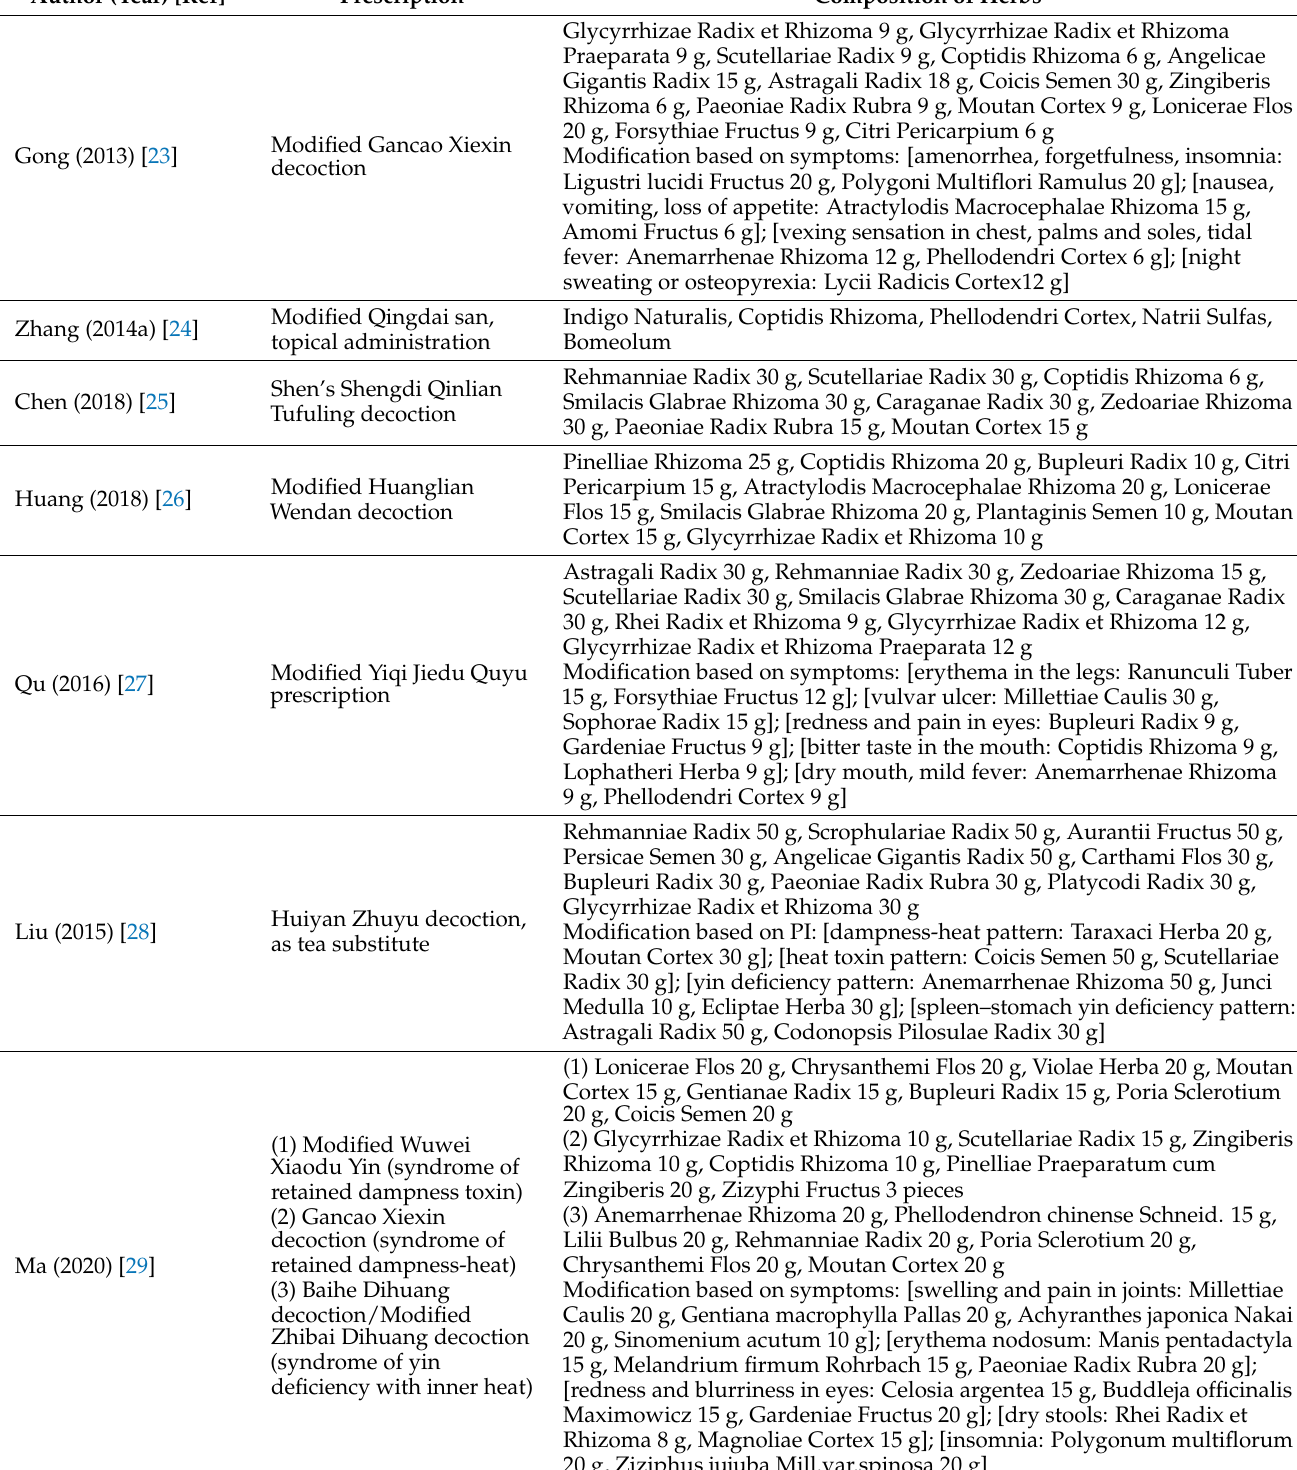
Table 2. Compositions of the herbal medicines for the treatment of Behcet’s